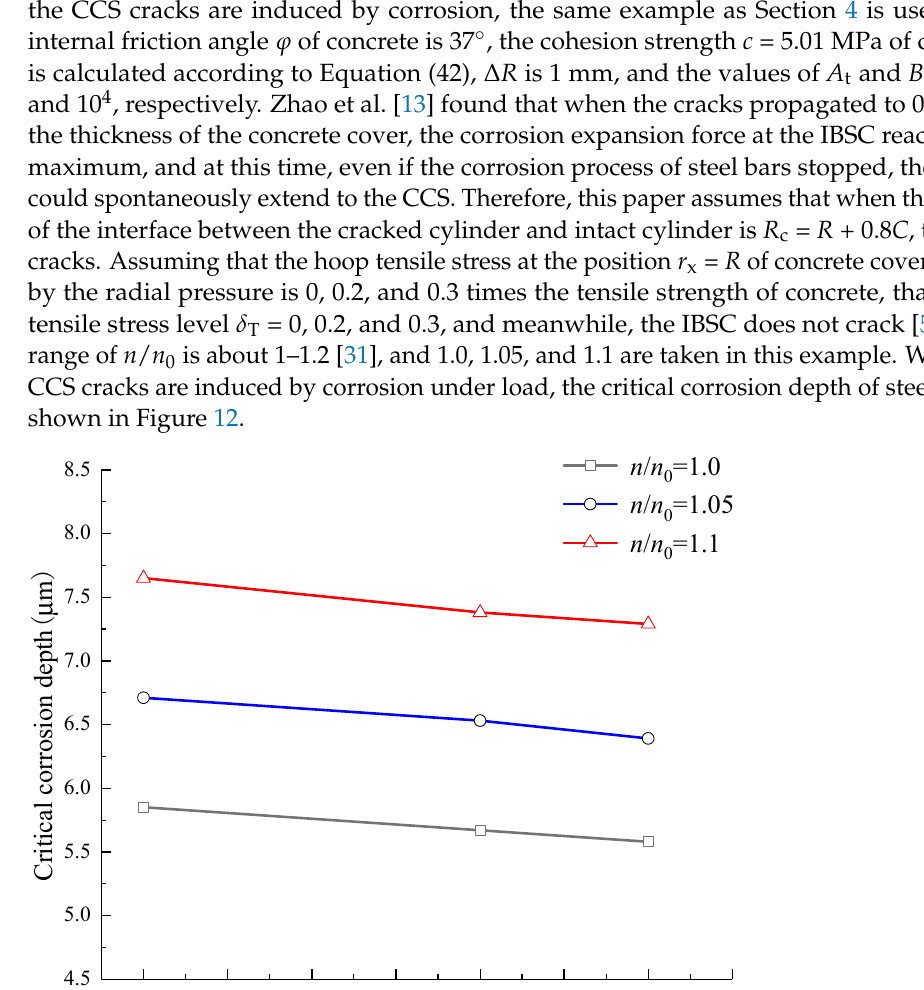
(57) When the current density of steel corrosion changes with time, the relationship between current density and time needs to be determined according to the measured